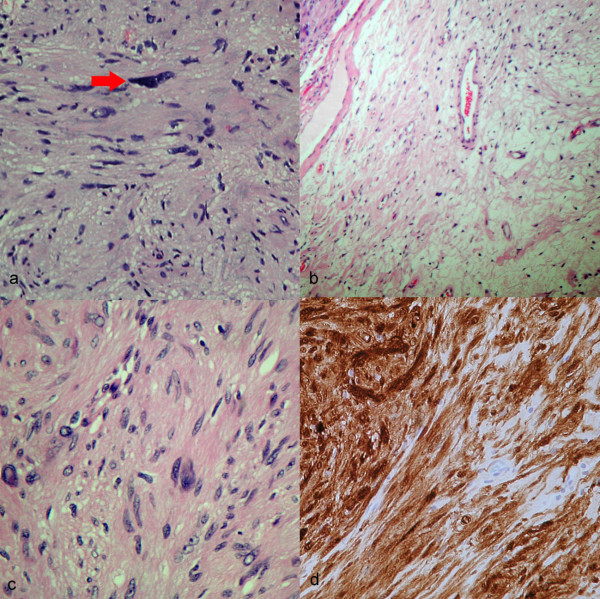
Microscopic appearance of ancient schwannoma. a) spindle cells in an Antoni type A area; a red arrow indicates a large bizarre hyperchromatic nucleus b) Antoni B areas consisting of spindle cells within a loose myxoid matrix, c) occasional pleomorphic nuclei within Antoni A areas, and d) positive S100 immunohistochemical staining.